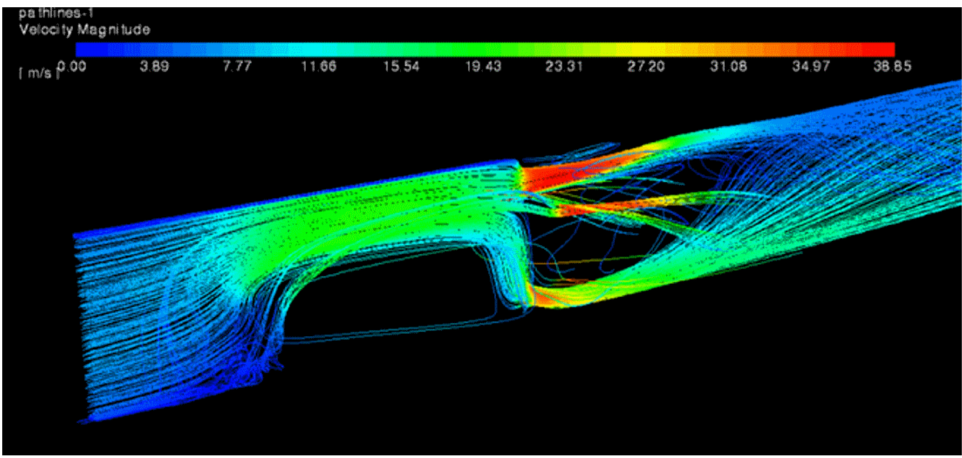
Figure 22. Streamlines for the case with disturbed flow displayed on horizontal cross-section.